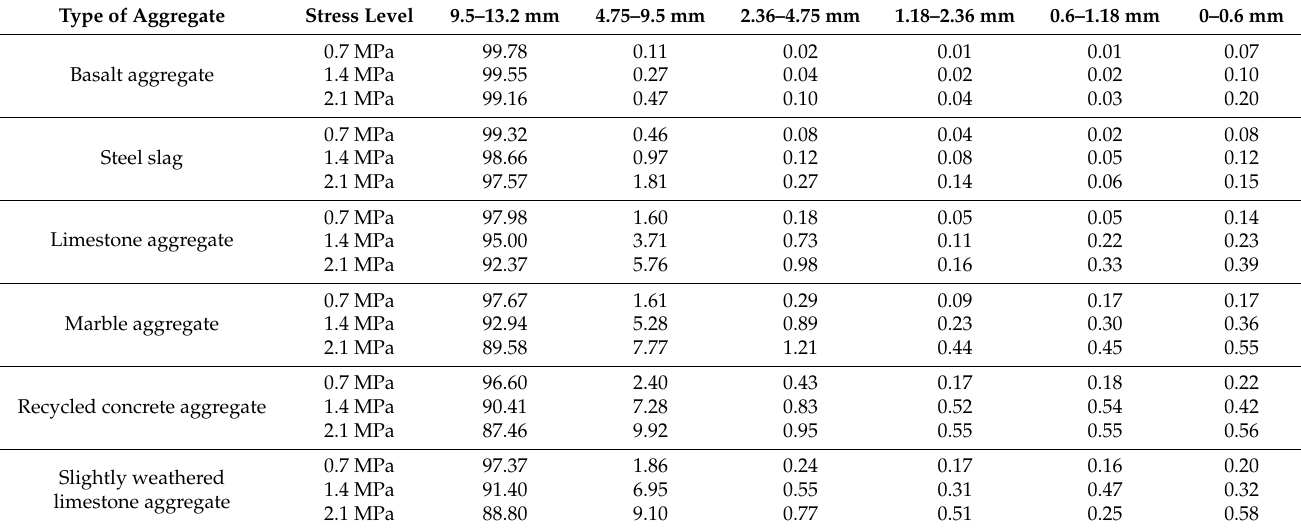
Table 5. Aggregate particle distribution after dynamic